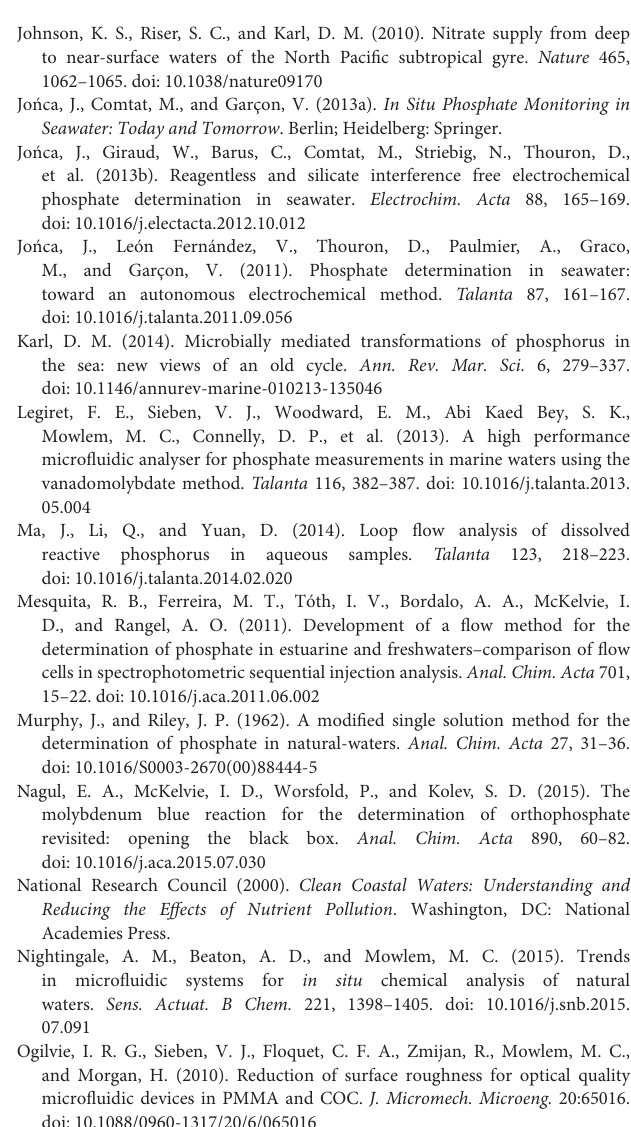
Figure S1 | Southampton water map. The sensor deployment location is shown with the red arrow. Imagery from Google Earth. Figure S2 | Map of Kaneohe Bay, Oahu, Hawaii. The deployment location, on the southwestern side of Coconut Island (Moku O Loe) is highlighted with the red circle. Imagery from Google Earth. Table S1 | Sensor analytical protocol when operated with two onboard standards. Table S2 | Target tank exposure conditions of the Nutrient Sensor Challenge laboratory tests. Table S3 | Reagents, blank, and standard(s) solutions consumption per analytical run (see Table S1 ). Also listed is the sample waste production, which includes